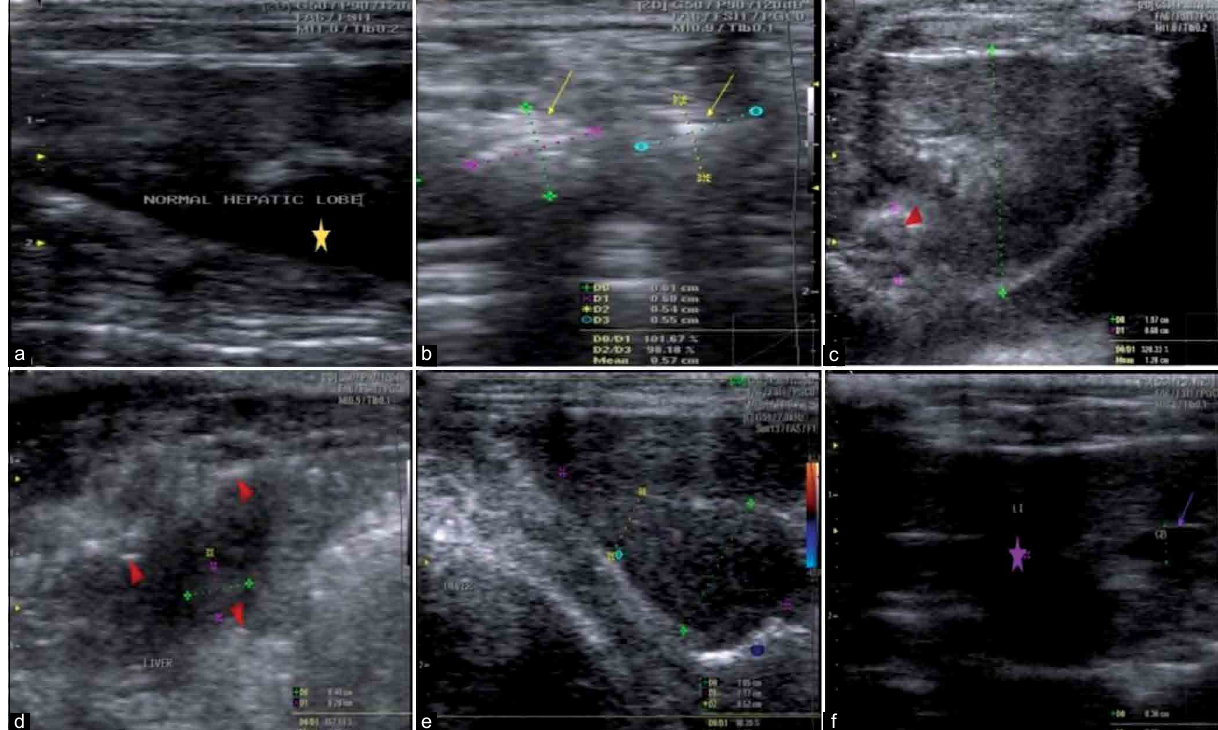
Figure-8: Ultrasonographic hepatic pictures in different Toxocara vitulorum -rat models. (a) Normal liver ultrasonography image was observed in healthy control rats showing homogeneous parenchyma, with medium echogenicity level and a regular surface of liver (yellow star). (b) Liver of untreated T. vitulorum -rat model with diffusely higher echogenicity of heterogeneous parenchyma and multiple foci of fibrosis (yellow arrows) with average size 0.57 cm. (c) At the 2 nd week following albendazole treatment, a hypoechoic regenerative nodule (red arrowhead) with a mean diameter reached 0.6 cm. (d) At the 4 th week following albendazole treatment, the liver ultrasonography image showed hyperechoic of the parenchyma and liver surface appeared as a slightly irregular line (red arrowheads). (e) At the 2 nd week after albendazole treatment with BMMSCs transplantation, ultrasonography image showed normal liver lobe of rats with homogeneous parenchyma, medium level echogenicity and regular surface, diameter 1.05×2.17×0.52. (f) At the 4 th week after albendazole with BMMSCs transplantation, liver showed an improvement in the hepatic lobe presented by homogeneous hepatic parenchyma with medium level echogenicity and regular surface (violet star) and gall bladder (violet arrow). BMMSCs=Bone marrow mesenchymal stem